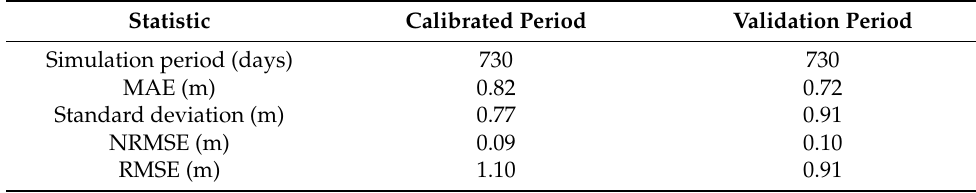
Table 5. Statistics of the residuals for the calibration and validation periods. Statistic Calibrated